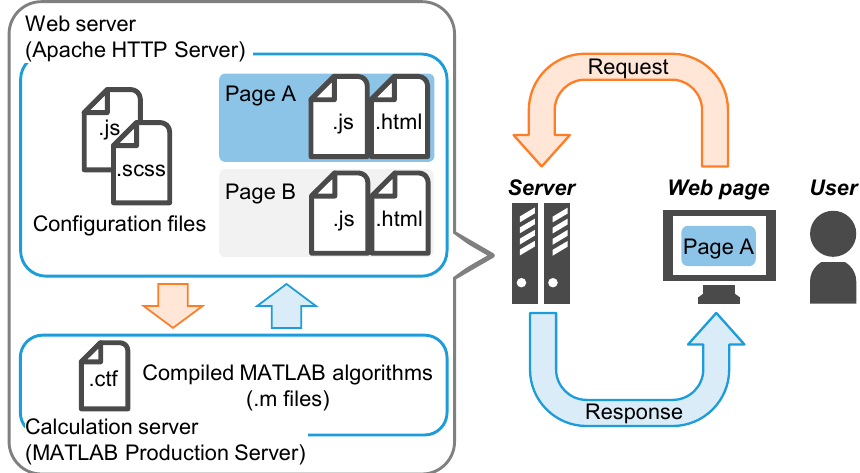
Figure 3. Structure of the online tool applying Hypertext Transfer Protocol (HTTP).